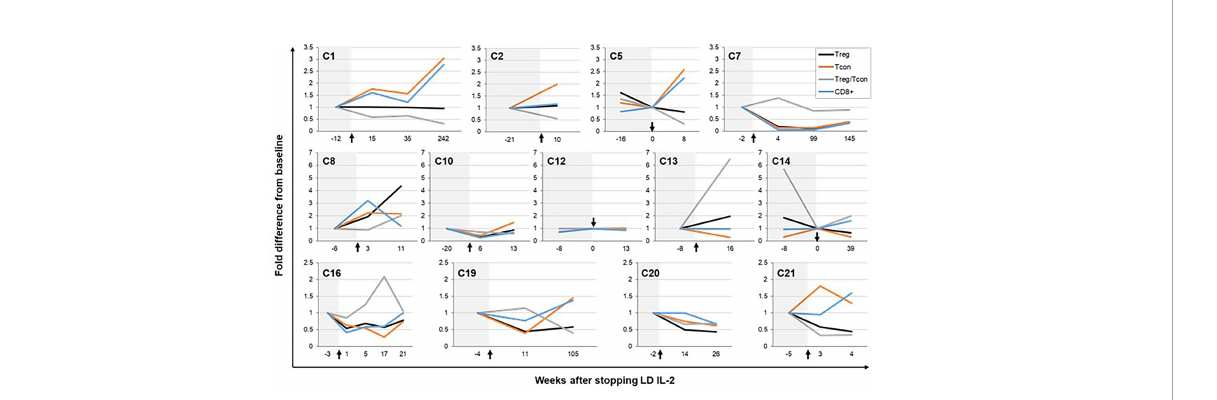
FIGURE 2 Immune responses after IL-2 discontinuation. Fold change from baseline in CD4+ regulatory T cell (Treg), CD4+ conventional T cell (Tcon), and CD8+ T cell numbers after stopping low-dose IL-2 therapy is shown for patients who had available immune cell data. Baseline was considered as the earliest time point prior to IL-2 discontinuation where immune cell data was obtained except for in 3 patients (C5, C12, and C14), who had data available on the day of IL-2 discontinuation (time point 0). Each graph represents data from an individual patient. Treg are represented by black lines, Tcon by orange lines, Treg/Tcon ratio by gray lines, and CD8+ T cells by blue lines. The time period prior to IL-2 discontinuation is shaded in light gray. Black arrows represent the time of IL-2 discontinuation.